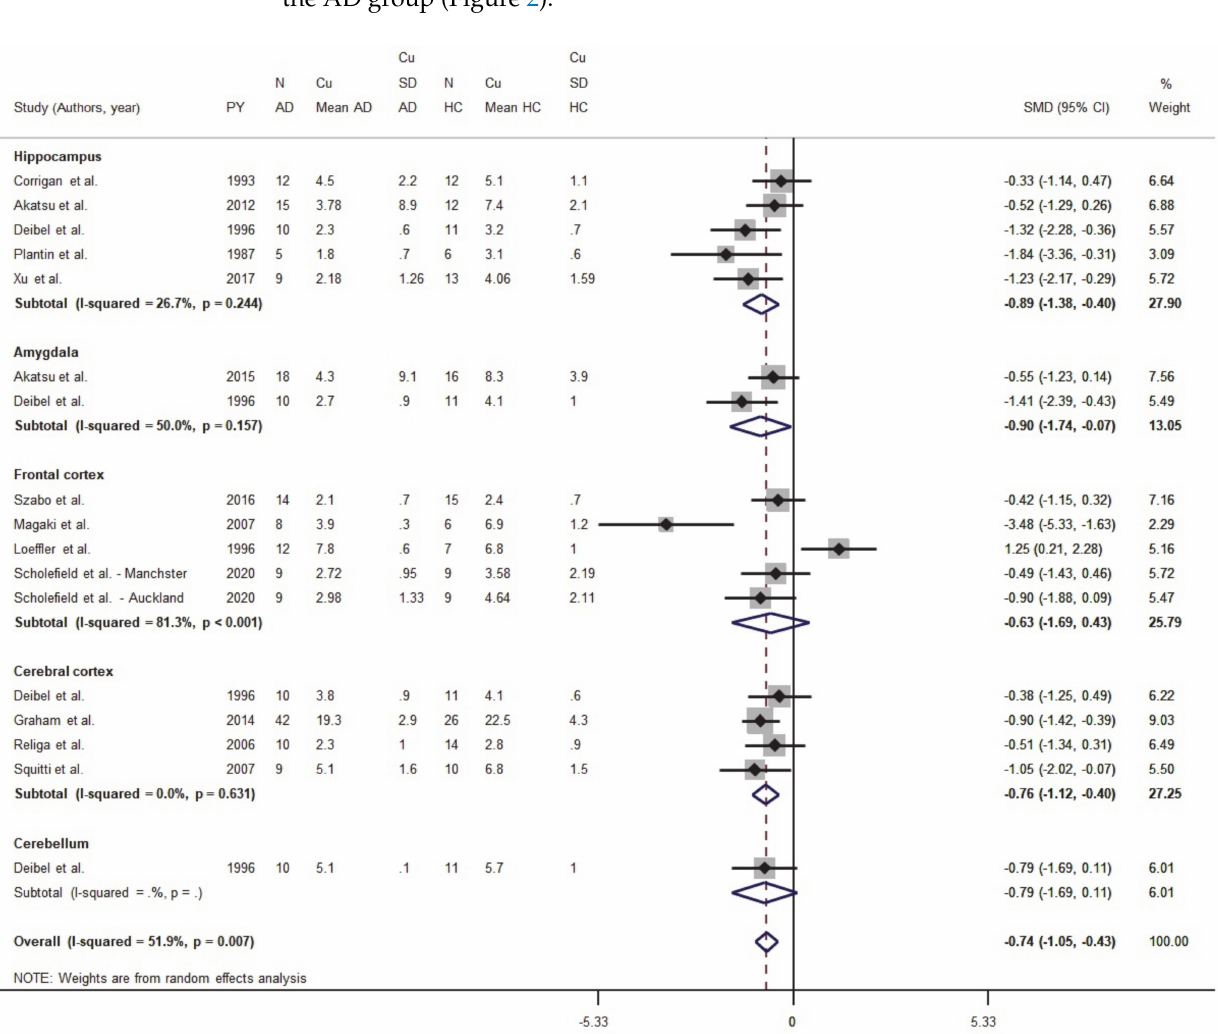
Figure 2. Standardized mean difference (SMD) computed from the studies on Cu brain levels ( µ g/g) in AD patients and HC subjects. SMDs between patients and controls are represented by squares, whose sizes are proportional to the sample size of the relative study. The whiskers represent the 95% confidence interval (CI). The diamond represents the pooled estimate based on the random-effects model, with the center representing the point estimate and the width indicating the associated 95%